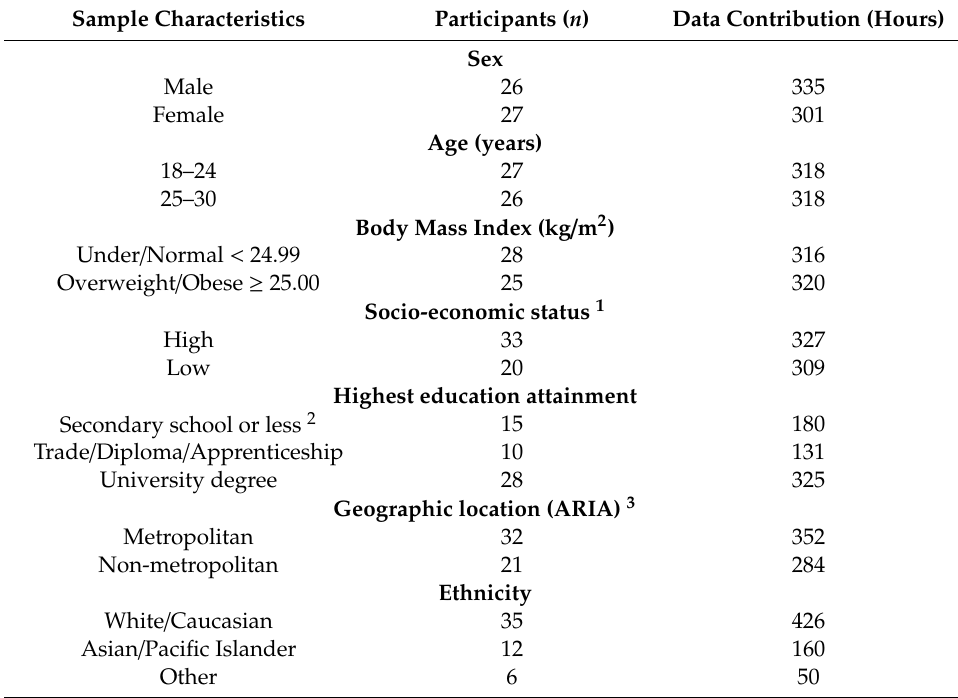
Table 1. Sample characteristics and data